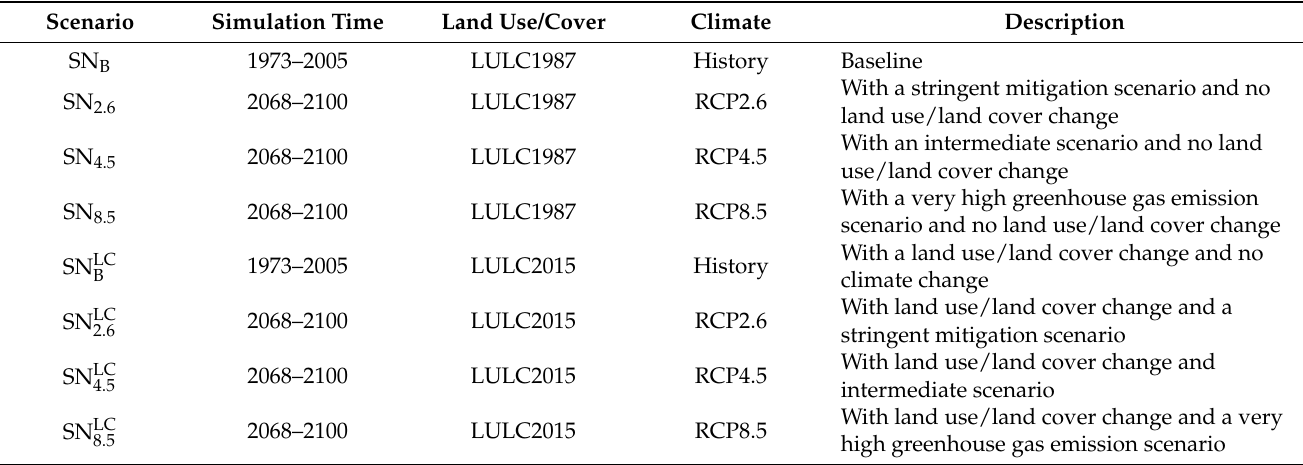
Table 1. The scenario analysis for characterizing the effects of climate change and land use/land cover change on the streamflow and